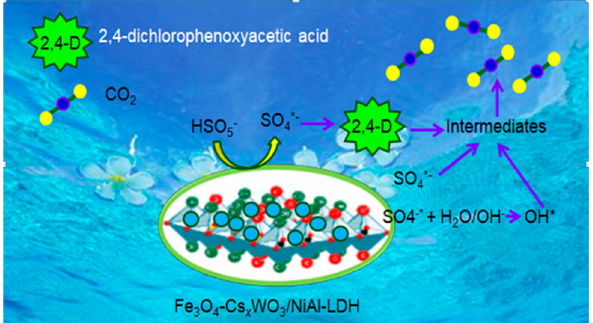
Figure 13: Schematic diagram of the photocatalytic process occur - ring on the surface of Fe 3 O 4 – Cs x WO 3 /NiAl - LDH composites. Reproduced with permission from ref. [ 115 ] ; copyright ( 2018 ) , American Chemical